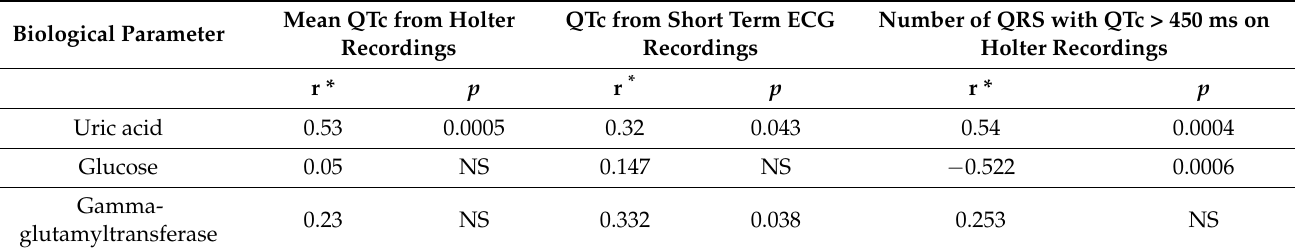
Table 4. Correlations between the QT interval and the biochemical